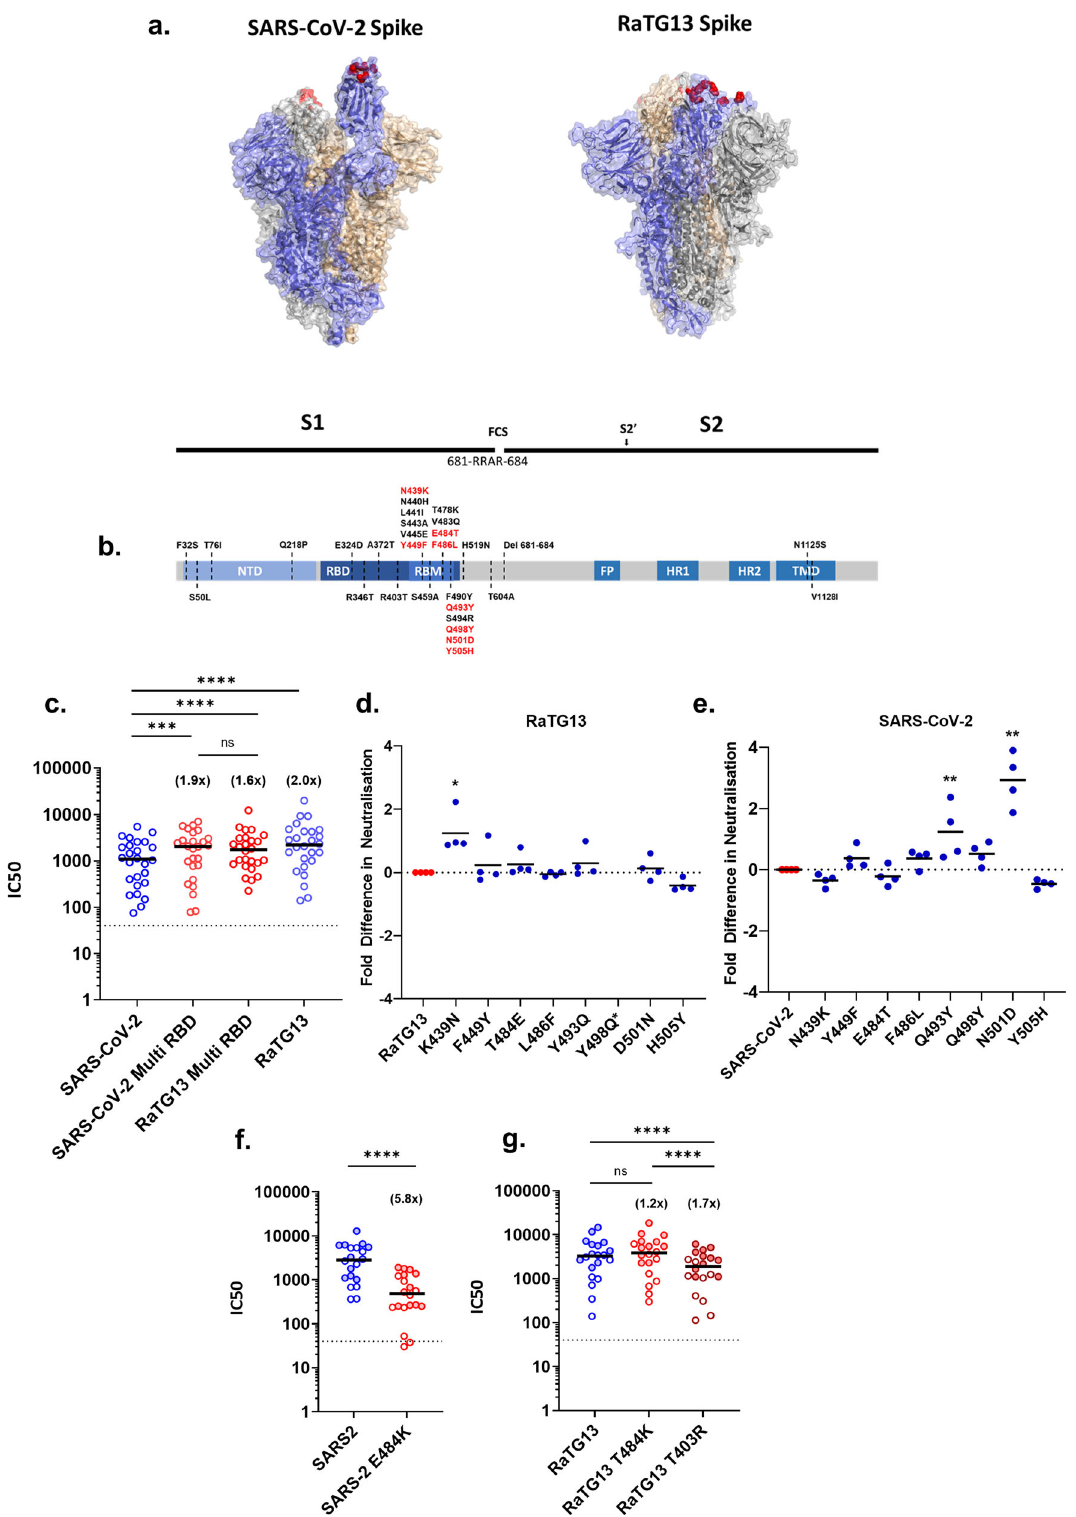
exception of K439N, which resulted in a mean 1.2 fold increase in neutralisation ( p = 0.0194) (Fig. 2d). In contrast, several individual substitutions in the SARS-CoV-2 background (Fig. 2e) showed signi fi cant increased neutralisation potency, with Q493Y showing a mean 1.2 fold increase ( p = 0.0088) and N501D a mean 2.9 fold increase ( p = 0.0069). These results highlight the importance of these particular residues in de fi ning